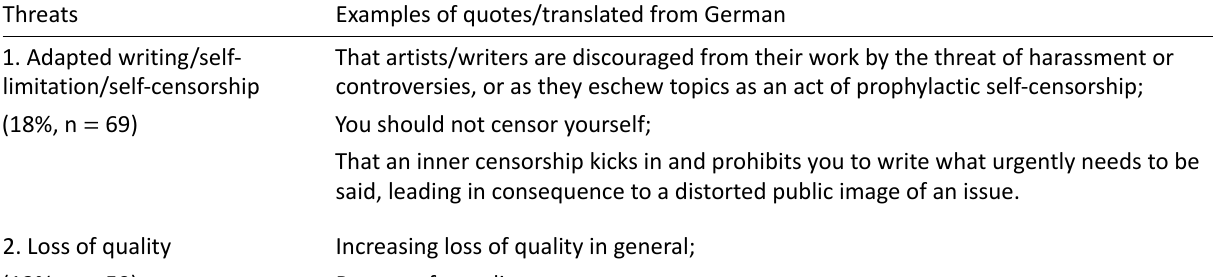
Table 4. Potential threats to the profession (open answers with examples of quotes). Threats Examples of quotes/translated from